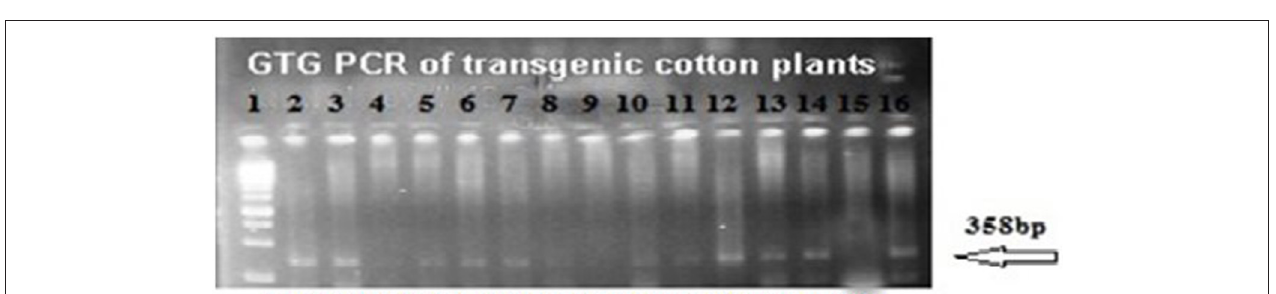
Frontiers in Plant Science |